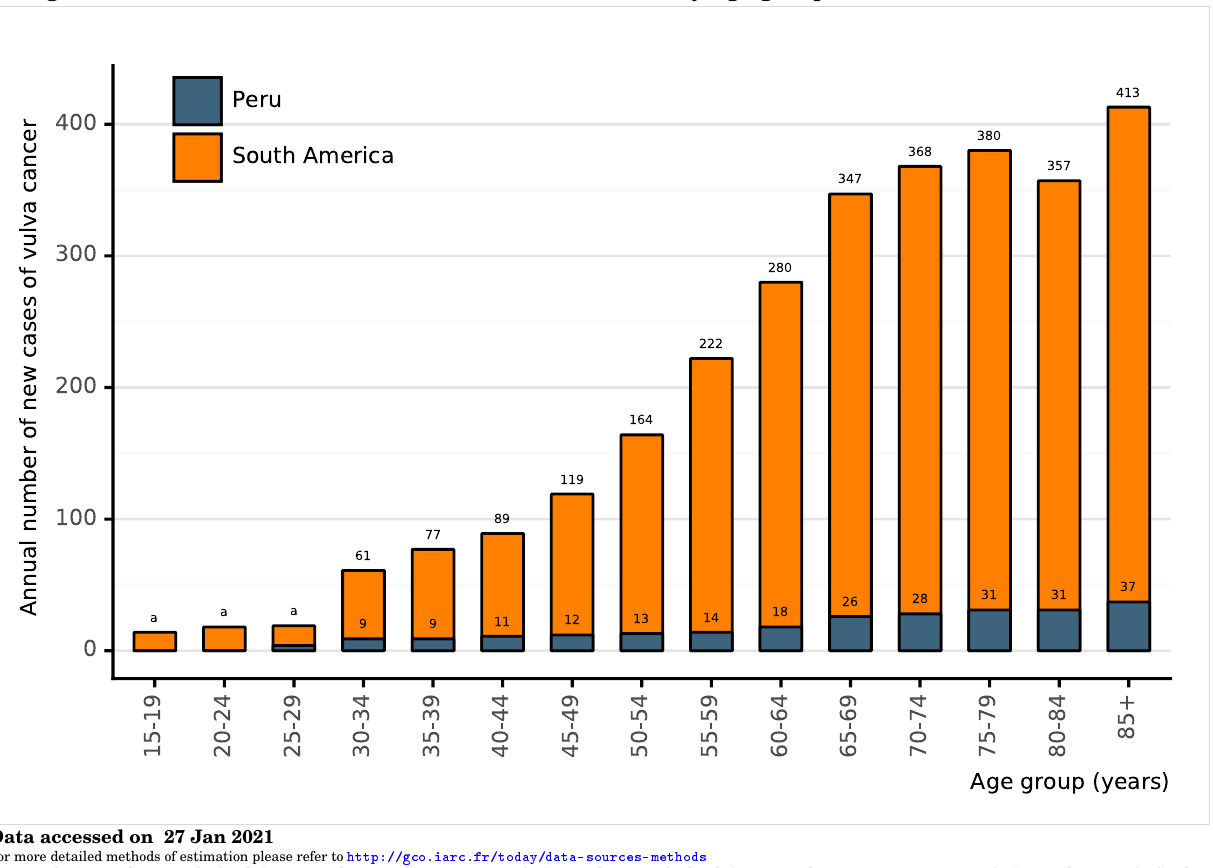
Figure 82: Annual number of new cases of vulva cancer by age group in Peru (estimates for